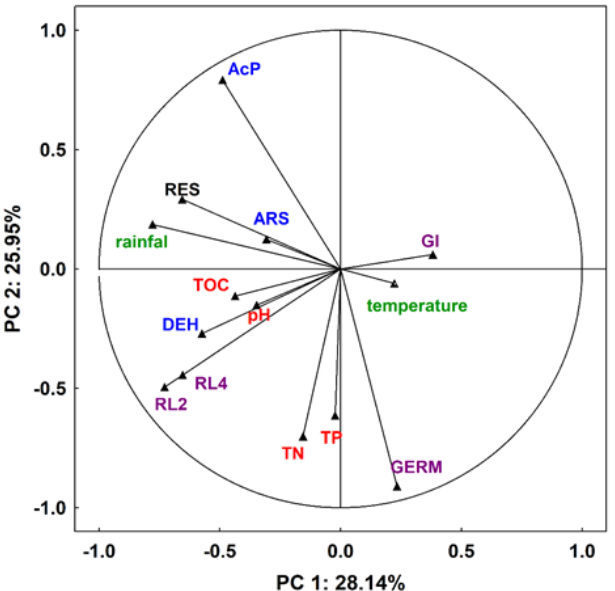
Figure 11. Principal component analysis (PCA) for the results of analyzed parameters in the soil- loading plot. RES—respiration of soil, DEH—dehydrogenases, ARS—arylsulfatase, AcP—acid phosphatase, GI—growth index of L. sativum , GERM—germination of L. sativum , RL2—root length of L. sativum after two days, RL4—root length of L. sativum after four days, TOC—total organic carbon, TN—total nitrogen, and TP—total